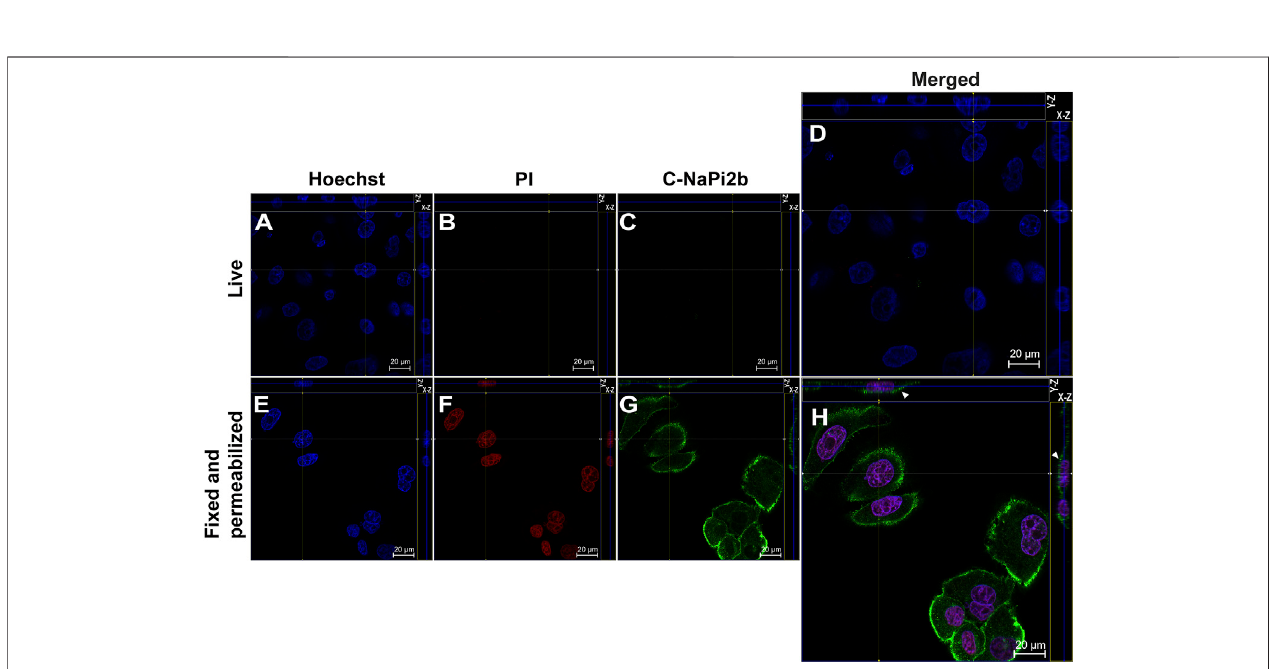
FIGURE 3 | Confocal microscopy analysis of the C-terminal domain of NaPi2b in ovarian carcinomas cells OVCAR-4 that were either alive (A – D) or fi xed and permeabilized (E – H) and imaged in the Z-stacking mode. (A,E) Blue channel (Hoechst); (B,F) Red channel (PI); and (C,G) Green channel (Alexa Fluor 488), C-NaPi2b – mAbs D3V3I(CellSignaling,UnitedStates) directedtotheC-terminaldomain ofNaPi2b; (D,H) Merged Images; Onthetop( Y -axisand Z -axiscombined)and right ( X -axis and Z -axis combined) of each image, a composite image comprising of numerous photographs obtained at various focus distances is shown. White arrows indicate the position of NaPi2b on the cell